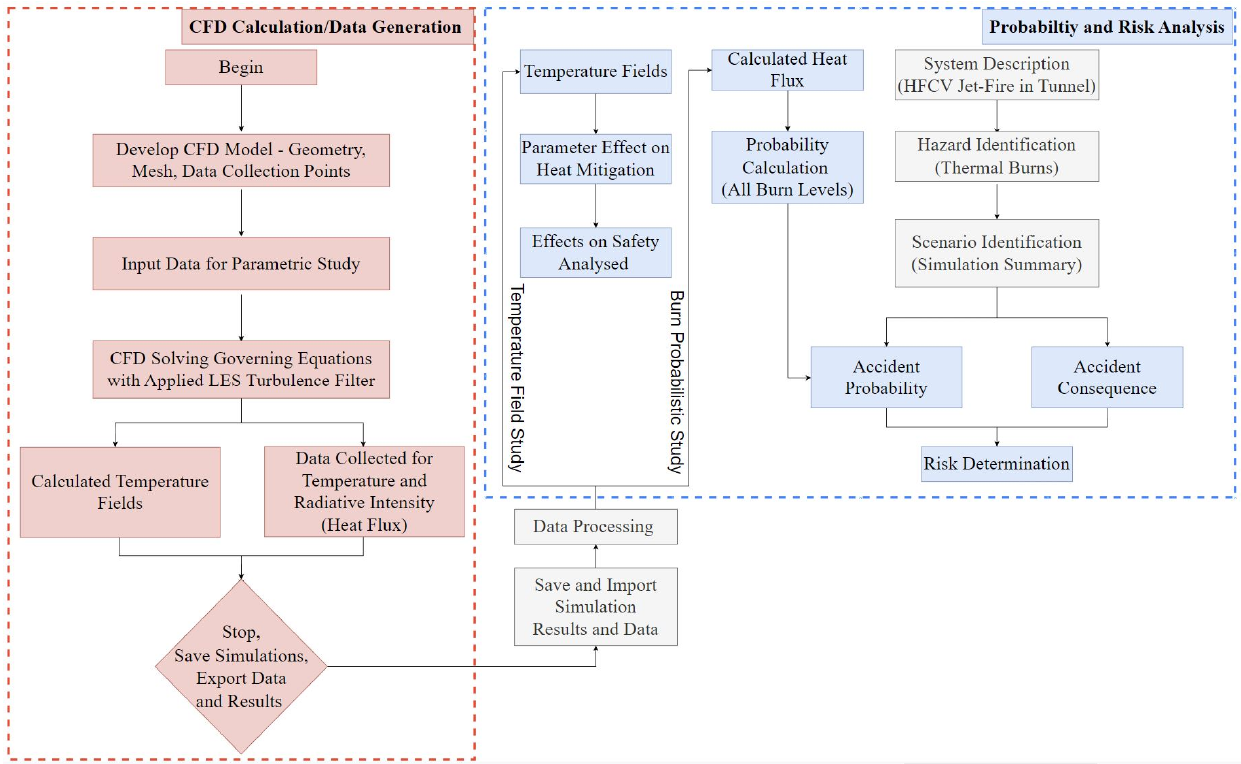
Figure 2. Methodology flowchart.